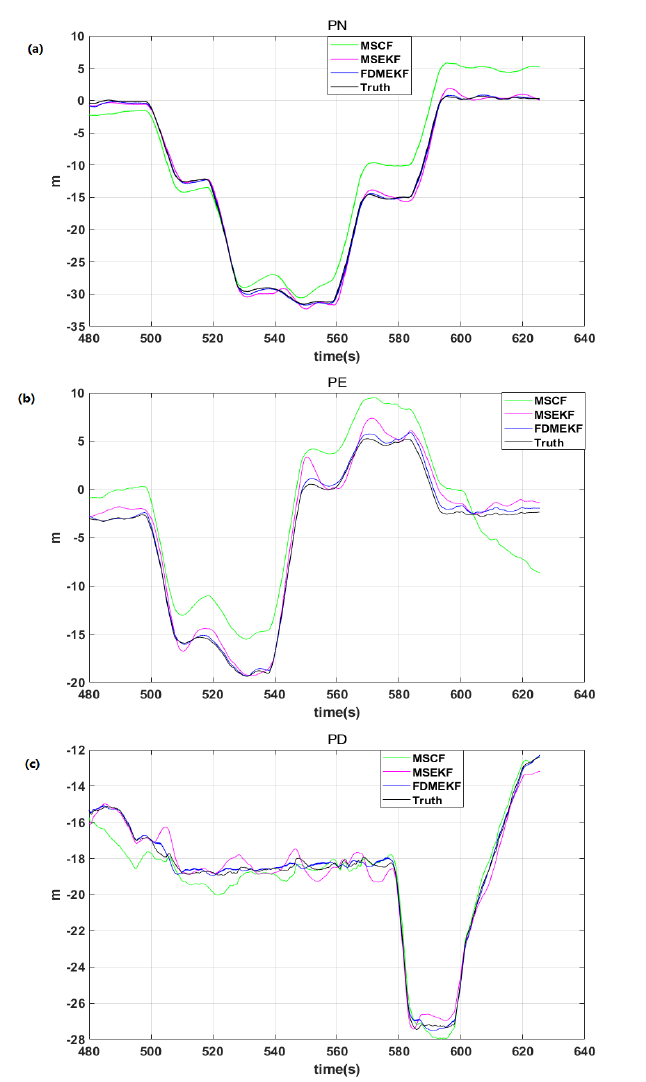
Figure 13. The position of the UAV in flight. ( a ) the north position of the UAV; ( b ) the east position of the UAV; ( c ) the down position of the